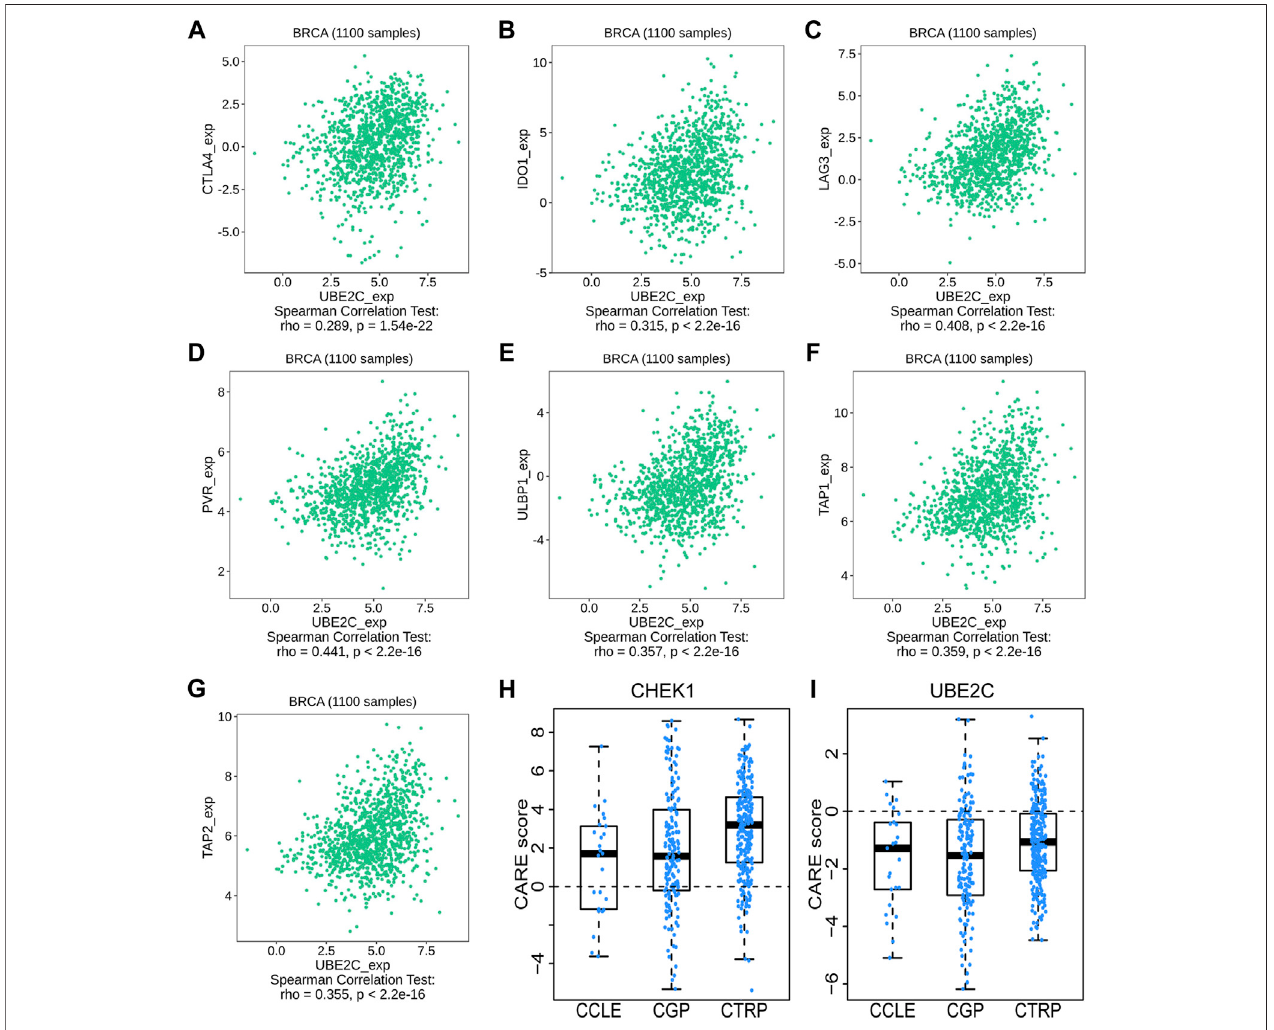
FIGURE 9 | Relations between the expression of UBE2C and immune checkpoints in BRCA. (A – C) Relations between three immunoinhibitors (CTLA4, IDO1, LAG3) and expression of UBE2C. (D,E) Relations between two immunostimulators (PVR and ULBP1) and expression of UBE2C. (F,G) Relations between two MHC molecules (MHC_TAP1 and MHC_TAP2) and expression of UBE2C. (H,I) The CARE score of CHEK1 (H) and UBE2C (I) on CCLE, CGP, CTRP dataset.